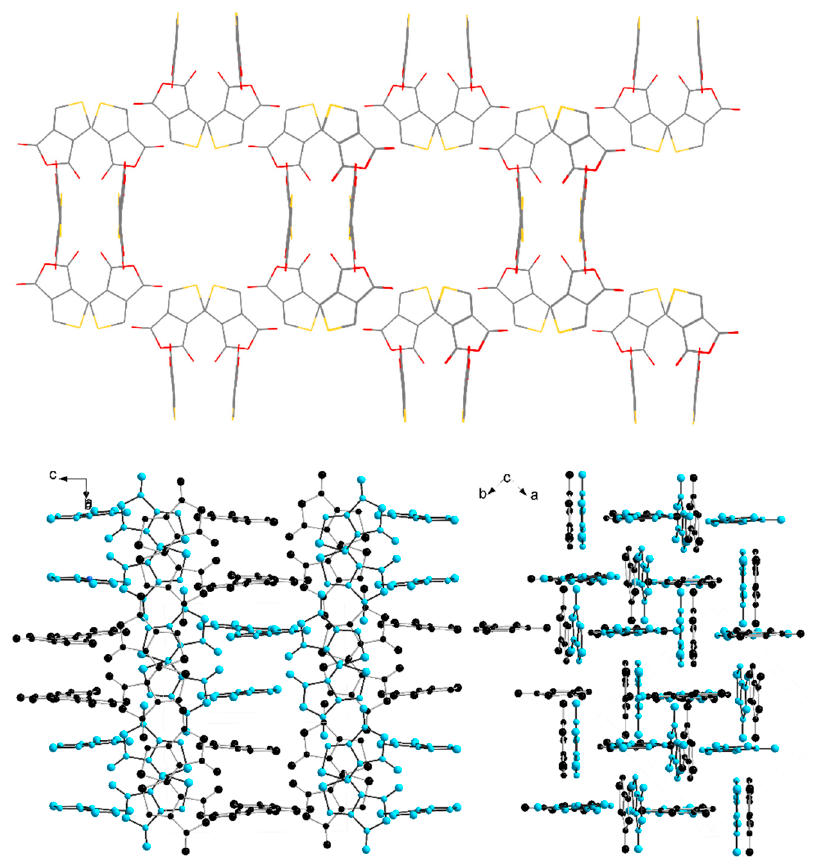
Figure 6. Combination of the interaction pattern of 4 , described in Figures 4 and 5 ( top ), and two interpenetrating networks of strong O···S interactions that complete the packing in the solid state of 4 .